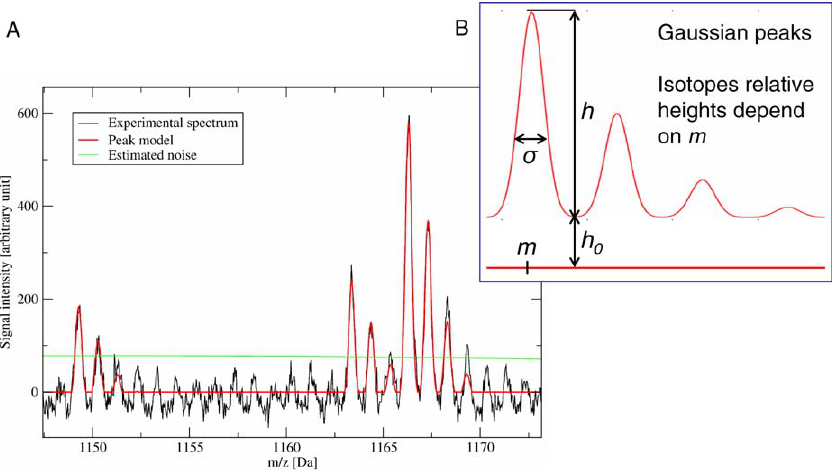
Figure 3. Peak Detection